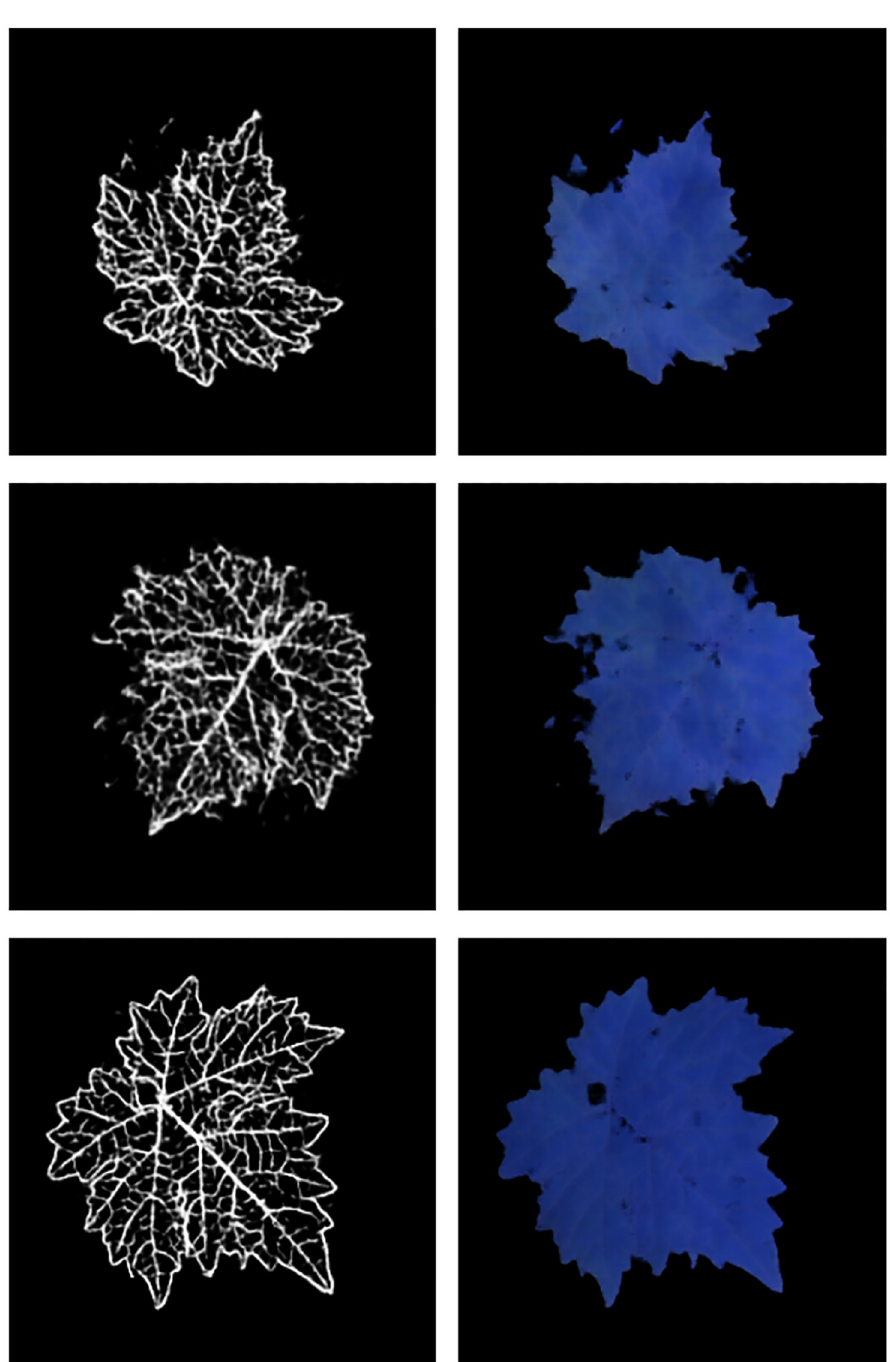
Fig 7. L2L-RGNIR translation results. Examples of synthetic leaves colorized in the RGNIR channels along with the corresponding synthetic companion skeletons.